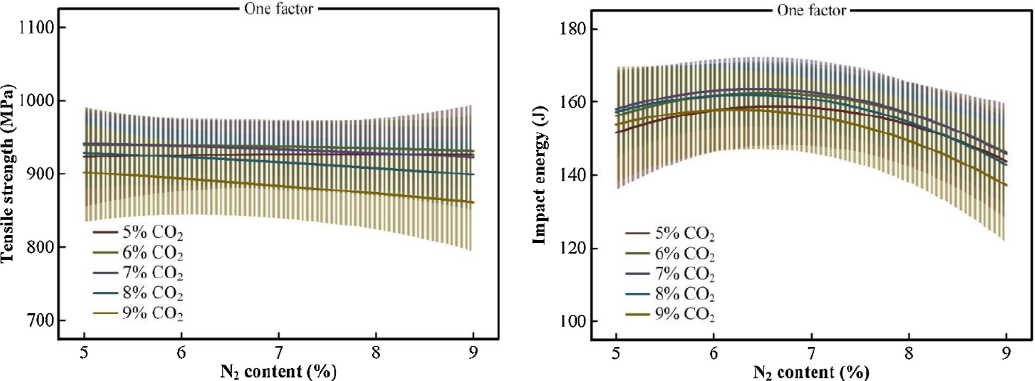
Figure 11. Effect of N 2 and CO 2 content in the shielding gas Ar-N 2 -CO 2 on mechanical properties. Reprinted with permission from ref. [25]. Copyright 2020, Elsevier.